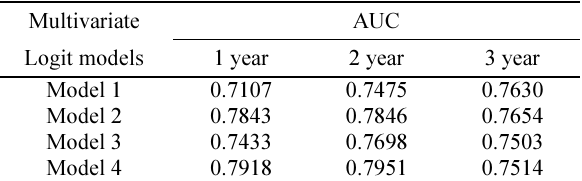
Table 7. Result of AUC of four multivariate Logit models Multivariate AUC Logit